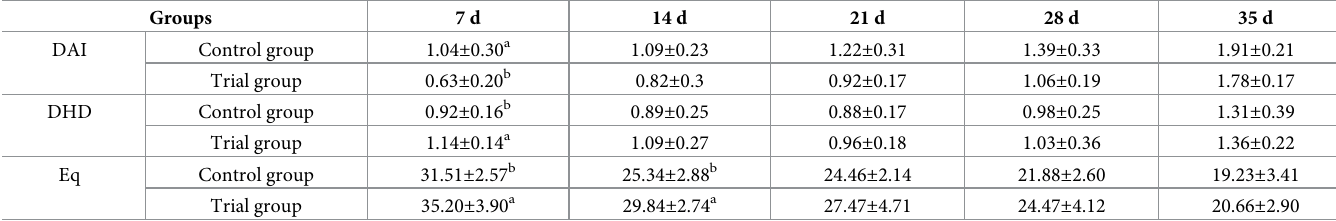
Note: In the same row, the values with different lowercase superscripts indicate a significant difference ( P < 0.05), whereas those with same lowercase letter or no superscript letters indicate no significant difference ( P > 0.05). In the same row, the values with a different capital letter indicate an extremely significant difference ( P < 0.01).